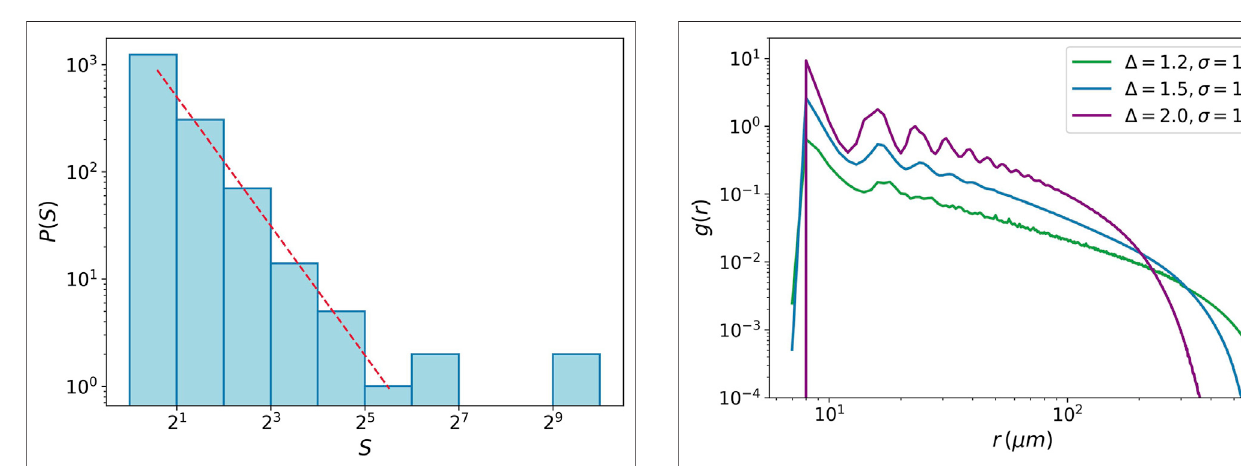
FIGURE7| Histogramforcomponentsizeattransitionpoint Δ =1.5.We gather data for the component size from 20 simulations. The red dashed line shows power-law function with the exponent − 2.